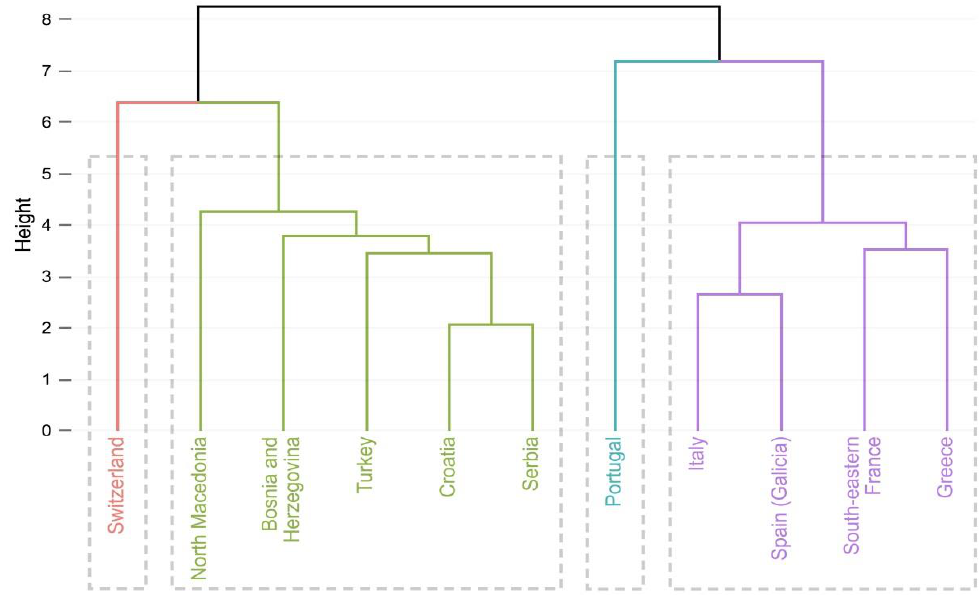
Figure 12. Hierarchical cluster analysis based on the average ratings of the fire causes by experts.